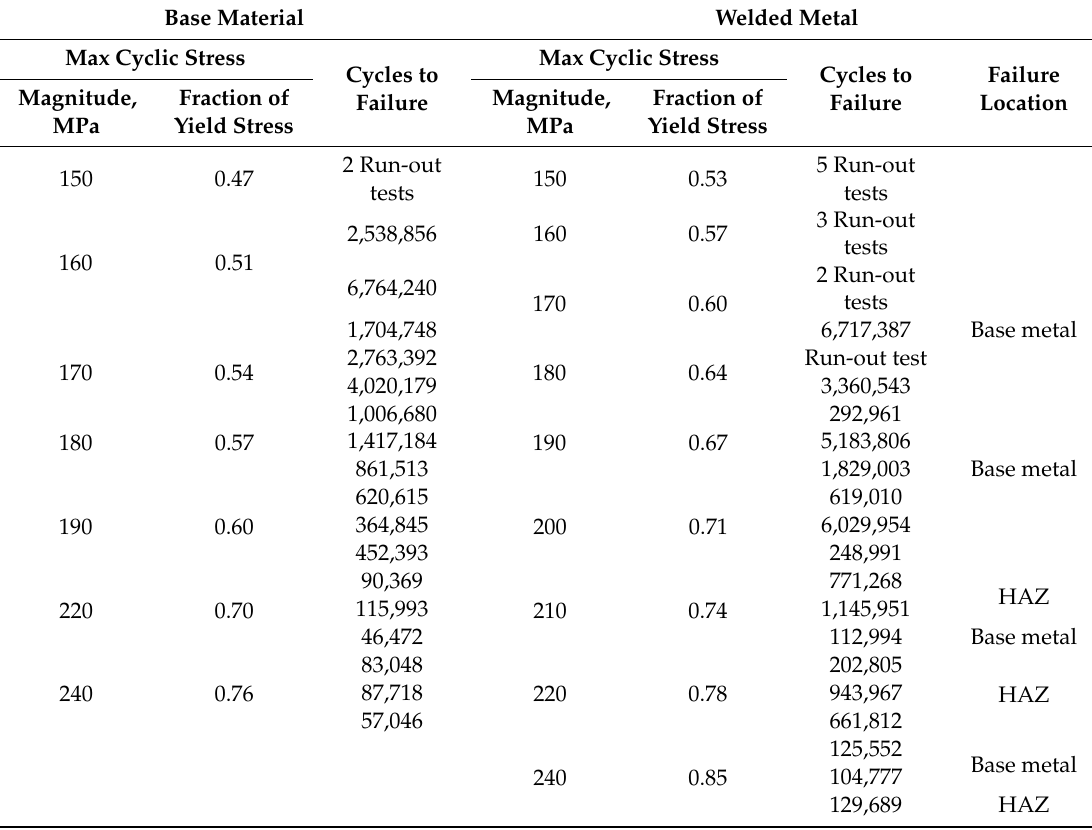
Table 6. Results of fatigue tests of 6061